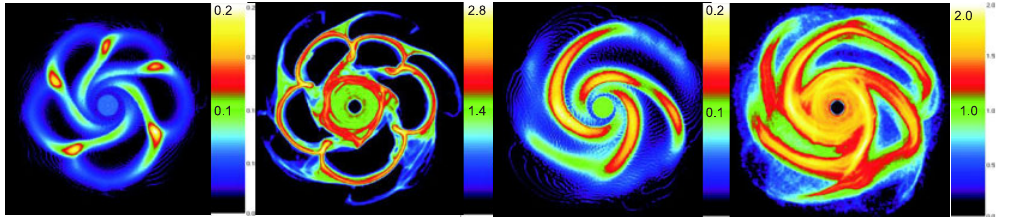
Figure 1. Surface density of gas (first and third column), and surface density logarithm of primary bodies (second and fourth column) at the time T = 22 for calculation with di ff erent v d . First and second column - v d = 0 . 01, third and fourth column v d = 0 .